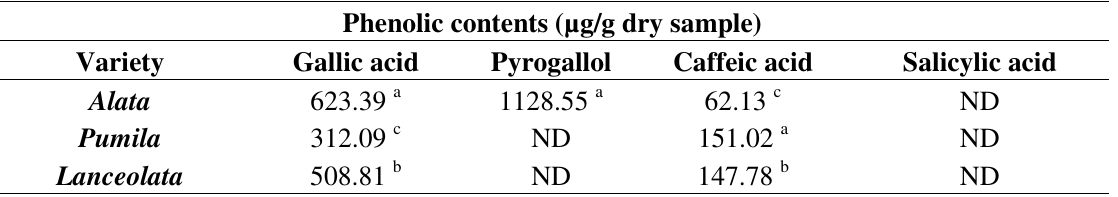
Table 6. Concentration of different phenolic compounds in the leaves of three varieties of Labisia pumila